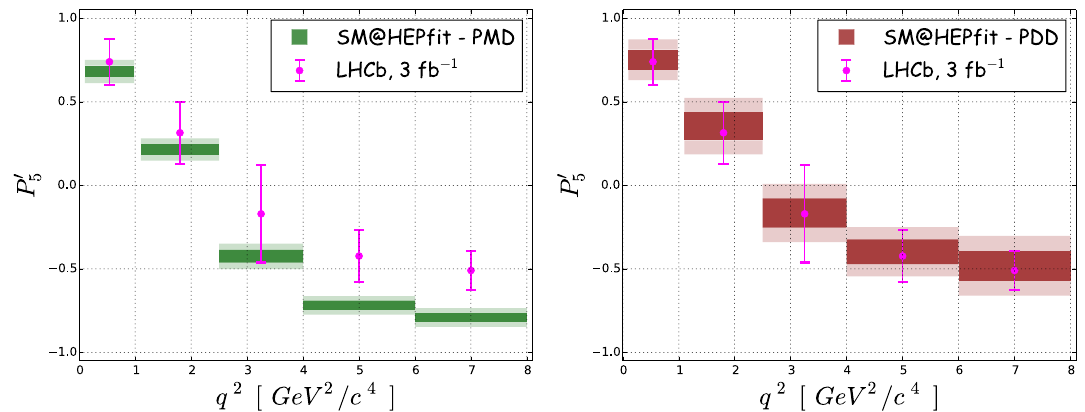
Fig. 2 ResultsofafitfortheLHCbresultsontheangularvariable P (cid:12) two different theoretical scenarios: assuming the validity of an extrap- olation of the QCD sum rules calculation of Ref. [133] at maximum hadronic recoil to the full kinematic range (left), or allowing for sizable